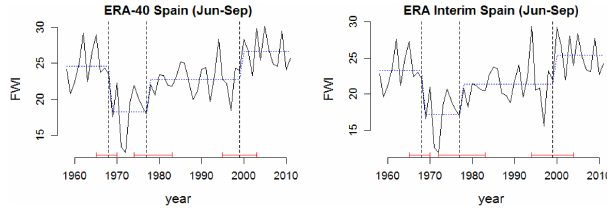
Figure 8. Breakpoints of FWI time-series data based on ERA-40 and ERA Interim for Spain. Vertical dotted lines correspond to breakpoints, while red horizontal lines correspond to the 95% con- fidence intervals of the estimated breakpoints. Blue lines represent the mean values of FWI for each identified